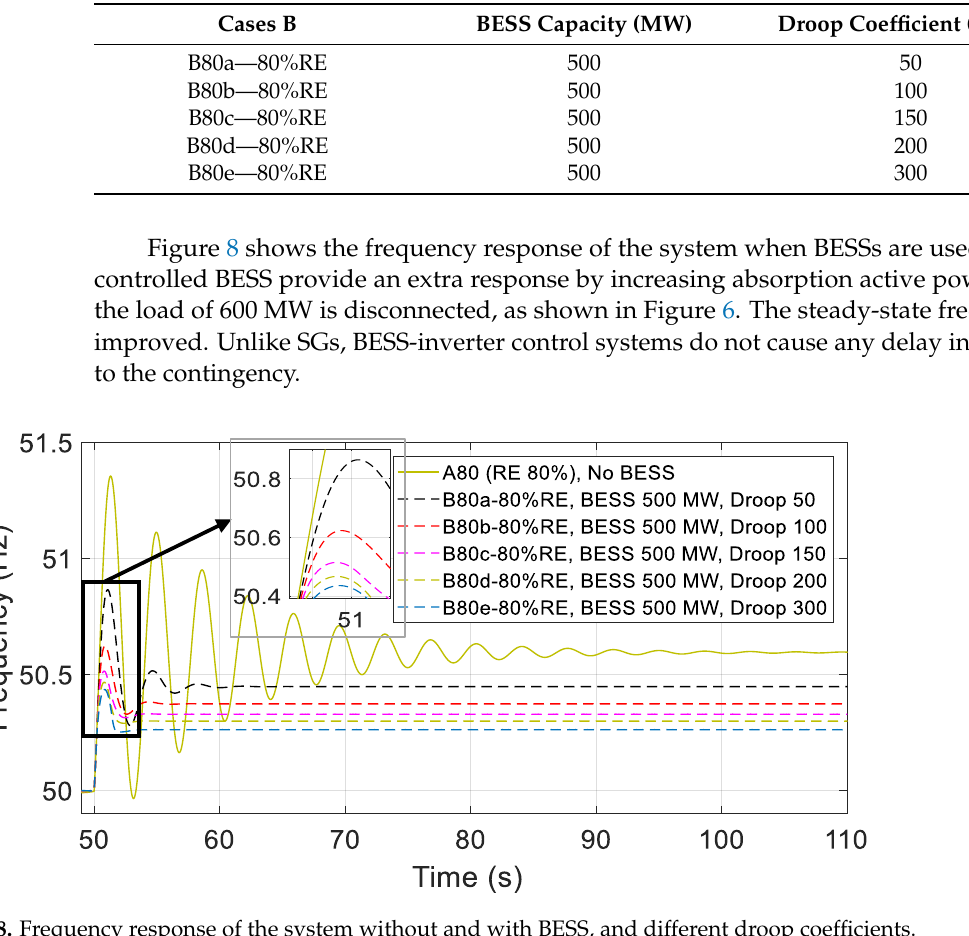
Figure 8. Frequency response of the system without and with BESS, and different droop coefficients.